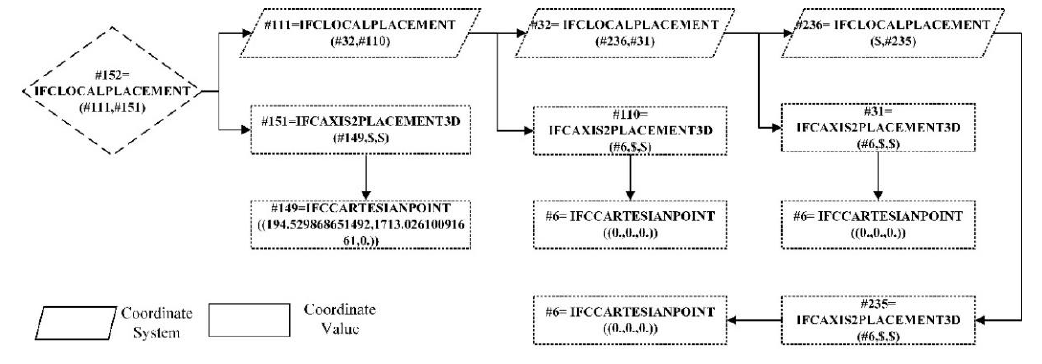
Figure 6. Example of position expression.